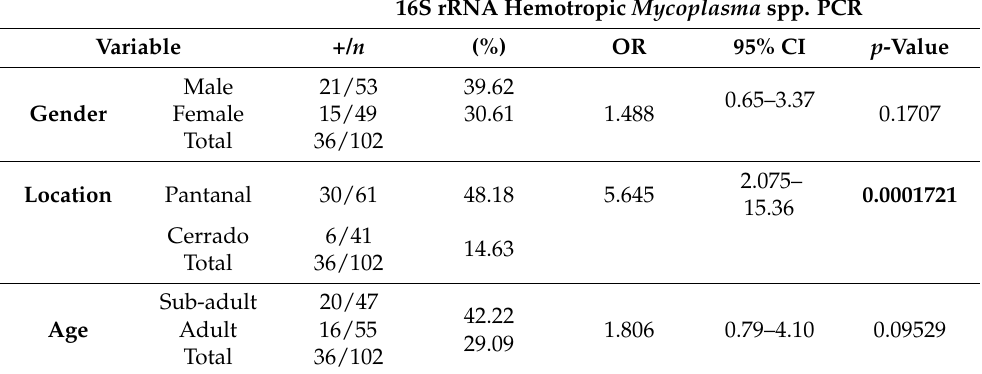
Table 7. Statistical analysis comparing the occurrence of hemotropic Mycoplasma sp. in sampled tapirs and outcomes (gender, sampling location, and